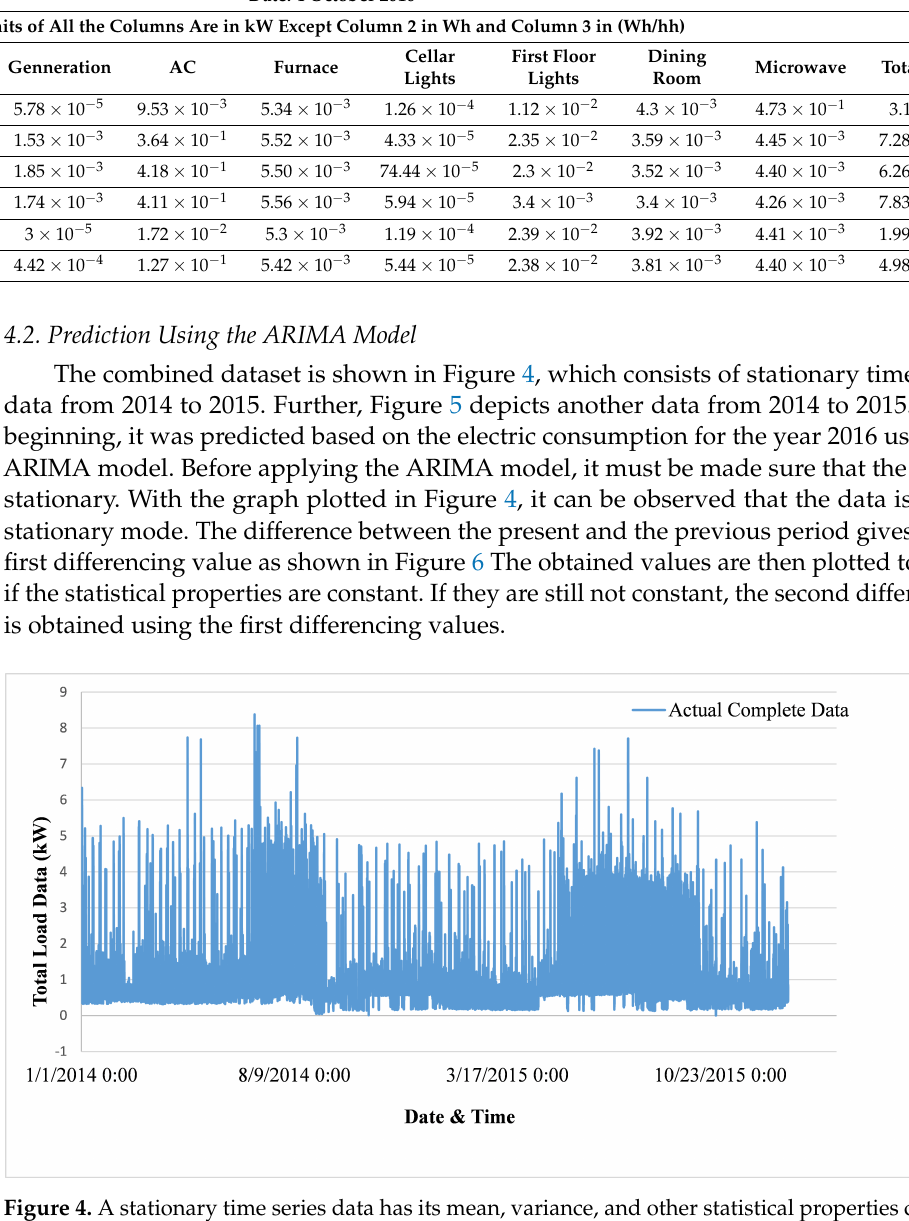
Table 5. Consumption dataset from the households. Date: 4 October 2016